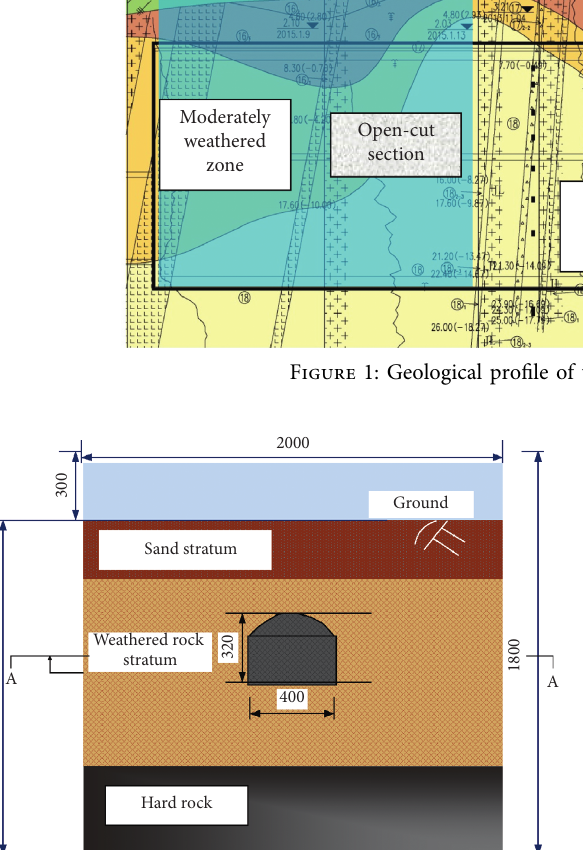
Figure 5. The physical and mechanical parameters of the prototype and model are listed in Table 1 [14].